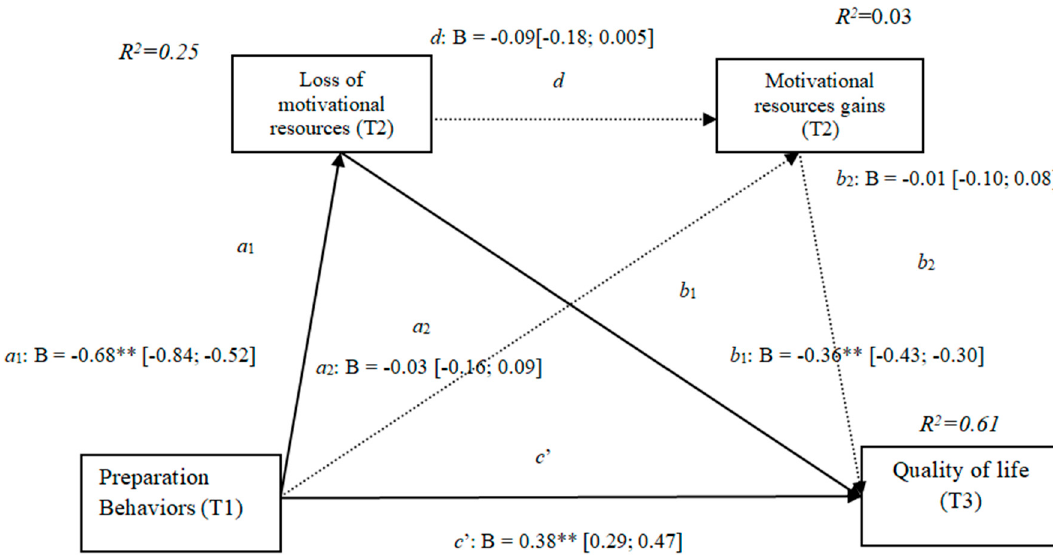
Figure 4. Non-standardized B coefficients, confidence intervals, and statistical significance for motivational losses and gains. [95% CI]; * p < 0.05; ** p < 0.01.